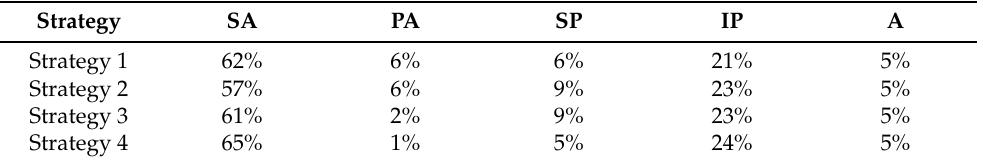
Table 2. Percentage dedication of time of faculty to the Mission by strategy.